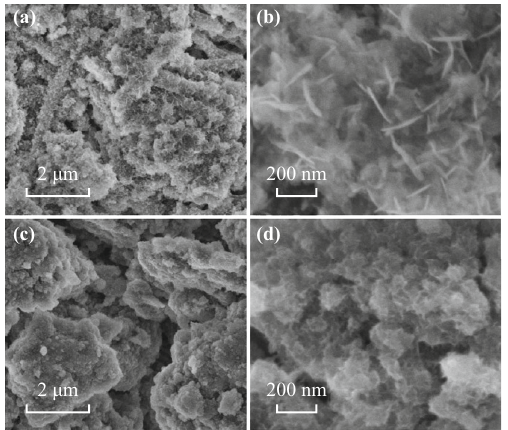
Fig. 7 SEM images of the electrodes after cycles for the Li-ion batteries: a , b NC@SnO 2 and c , d SnO